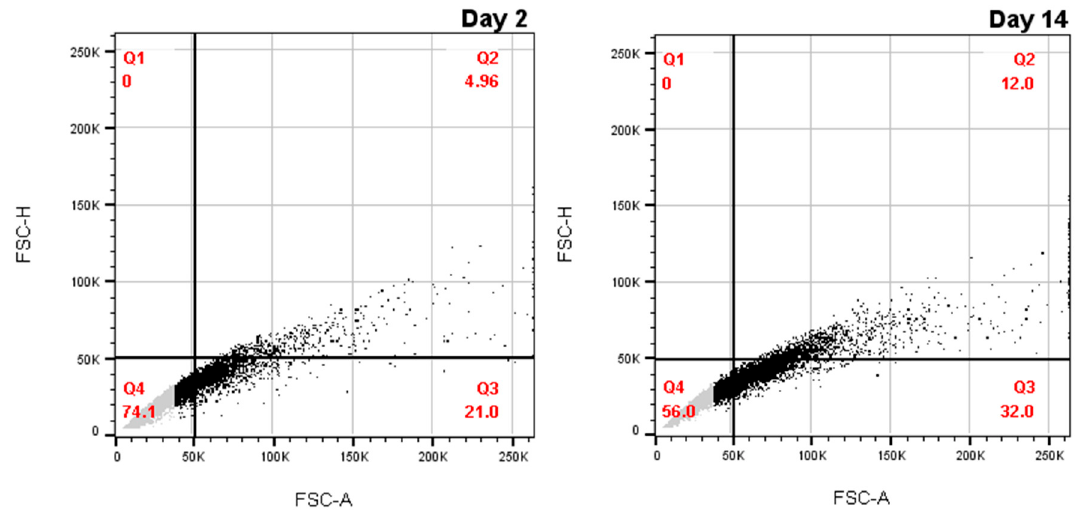
Figure A2. RNA (y axis) and DNA (x axis) distribution on days 4 and 9 of the bioreactor run at physiological temperature.